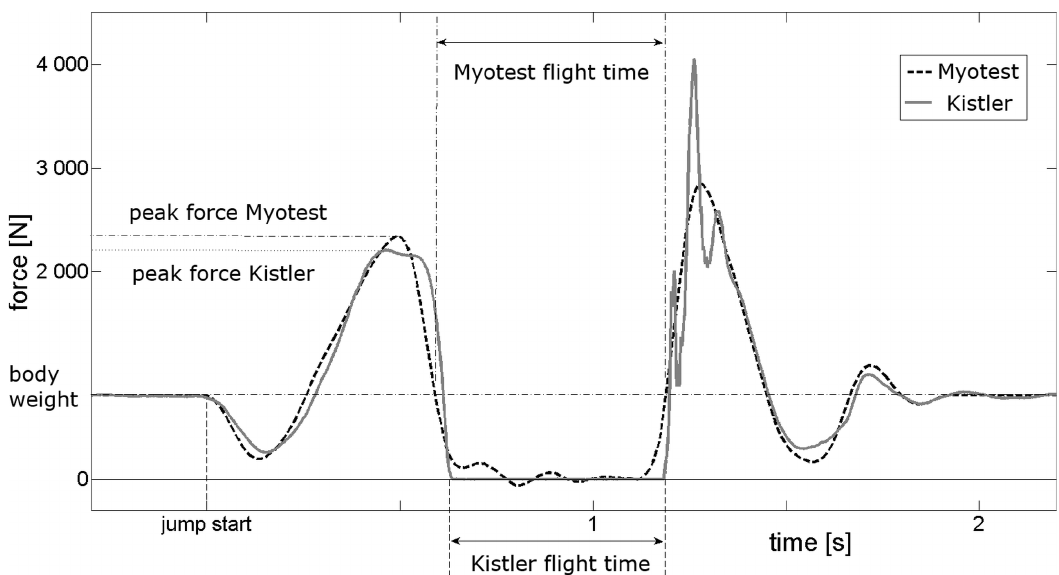
Figure 2. Example of the force-time curve during a counter-movement jump measured using the Myotest accelerometer and Kistler force plate. Graphic shows the flight time of the force plate mea- surement, registered when the force fell below 10 N; and flight time of the accelerometer measure- ment, registered when the force was below the subject’s bodyweight in Newtons. Although these data were collected at the same time, the temporal synchronization was performed after analysis, only to create this figure to depict the different force curves from each